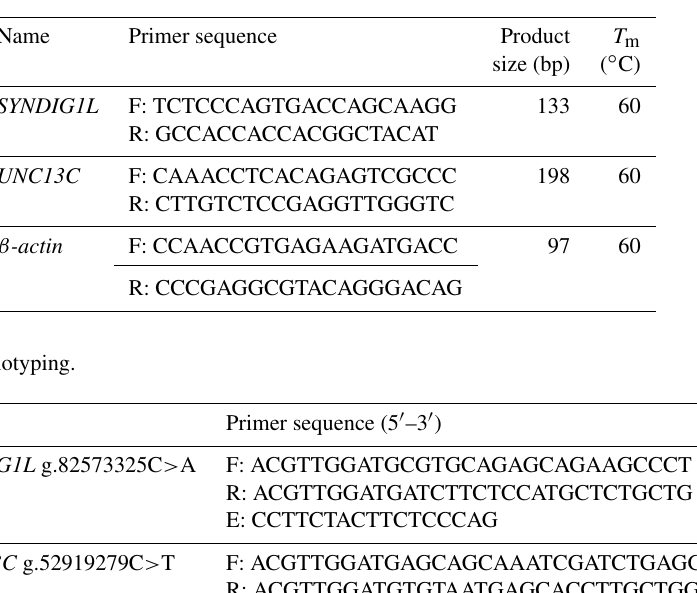
Table 2. The primer information for RT-qPCR.